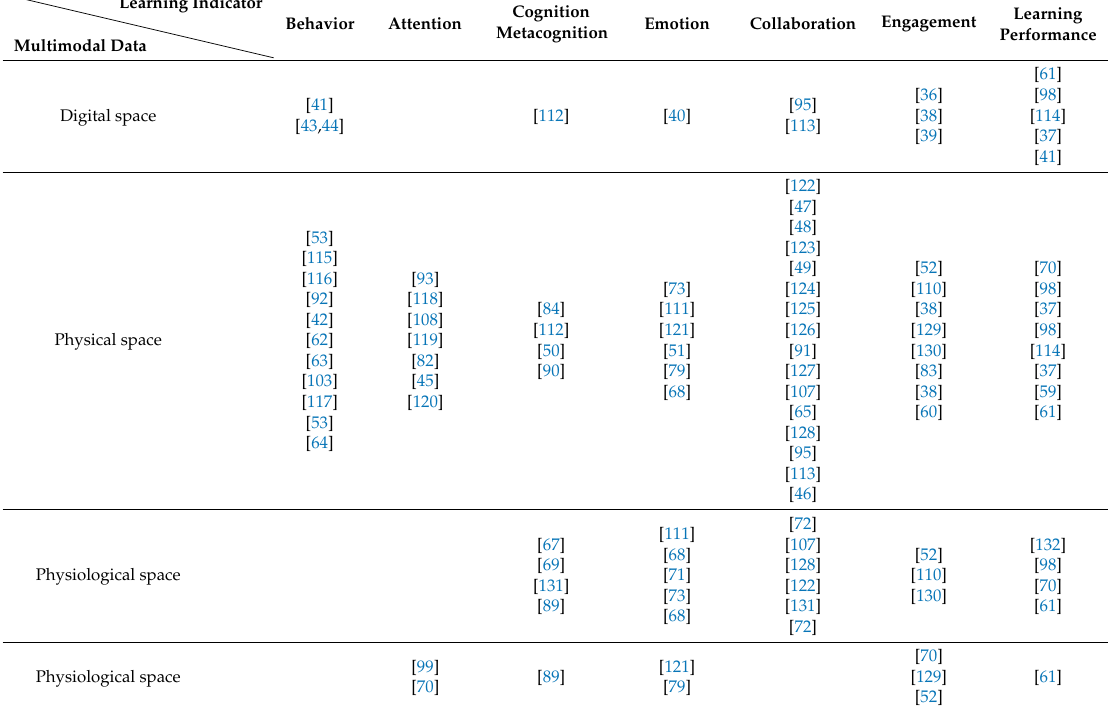
Table 5. The relationships between multimodal data and learning